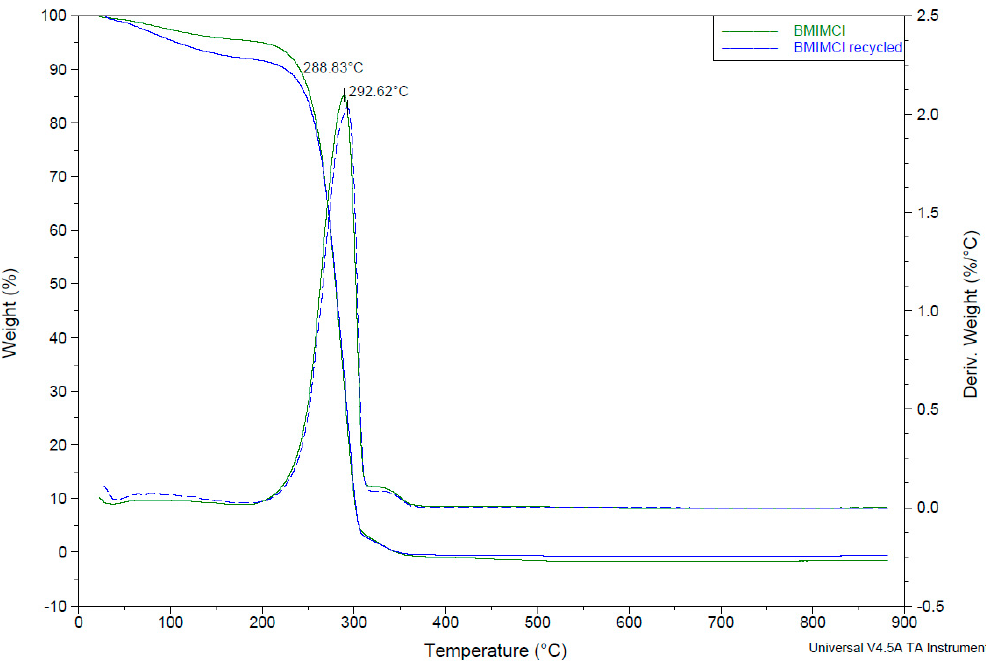
Figure 5. TGA of pure IL (green) and recycled IL (blue) between 0–900 °C represented as continuous lines, and their derivative weight (%/°C) represented as discontinuous lines.